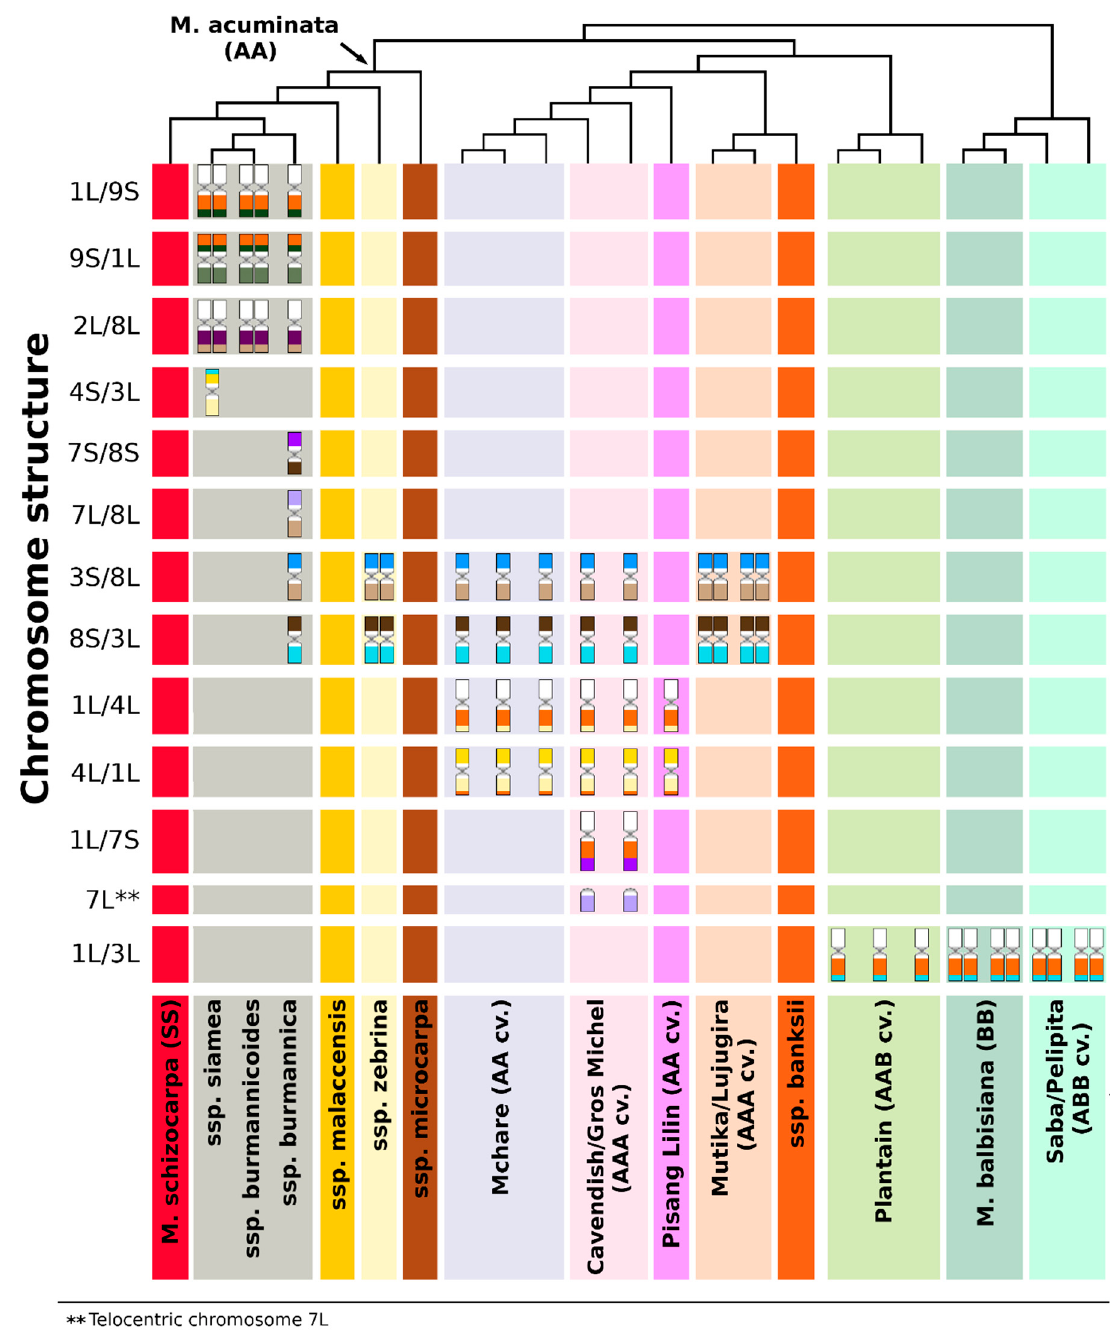
Figure 4. Overview of common translocation events revealed by oligo painting fluorescence in situ hybridization (FISH) in Musa : diversity tree, constructed using simple sequence repeat (SSR) markers according to Christelová et al. [28], shows the relationships among Musa species, subspecies, and hybrid clones. Lineages of closely related accessions and groups of edible banana clones are highlighted in different colors. Individual chromosome structures (displayed as chromosome schemes) are depicted in rows, and their number correspond to the number of chromosomes bearing the rearrangement in the nuclear genome in somatic cell lines (2n).